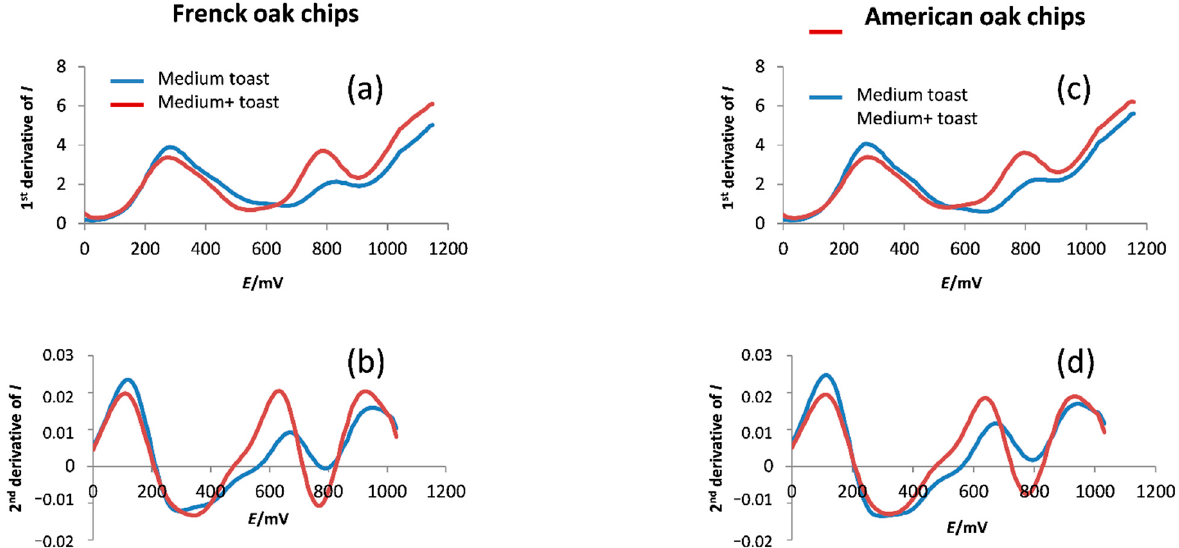
Figure 3. First ( a,c ) and 2nd ( b,d ) derivative voltammograms of French ( a , b ) and American ( c , d ) oak chips.